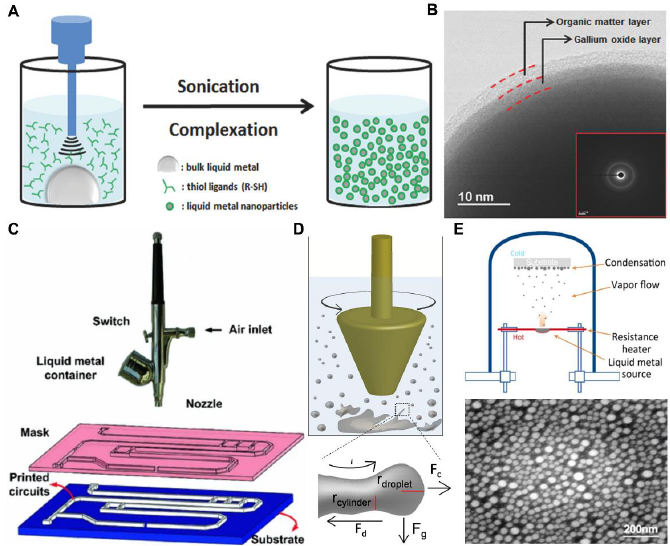
Figure 3. Fabrication methods of liquid metal (LM) droplets. ( A ) Schematic illustration of LM nanodroplets fabrication by ultrasonic cavitation. Reprinted with permission from ref. [87]. Copy- right 2016, John Wiley and Sons. ( B ) The core-shell structure of LM nanodroplets fabricated by ul- trasonic cavitation. Reprinted with permission from ref. [87]. Copyright 2016, John Wiley and Sons. ( C ) Schematic diagram of atomized spraying equipment for fabrication of LM droplets. Reprinted with permission from ref. [90]. Copyright 2013, Spring Nature. ( D ) Schematic diagram of SLICE and the structure of droplets. Reprinted with permission from ref. [91]. Copyright 2014, American Chemical Society. ( E ) Preparing LM droplets through physical vapor deposition technique. Re- printed with permission from ref. [92]. Copyright 2018, Elsevier.